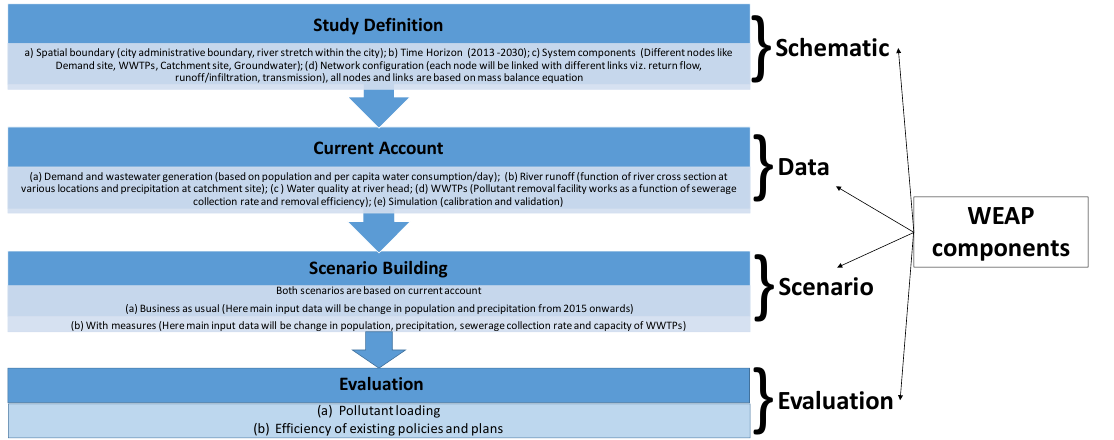
Figure 3. Flowchart showing model structure.